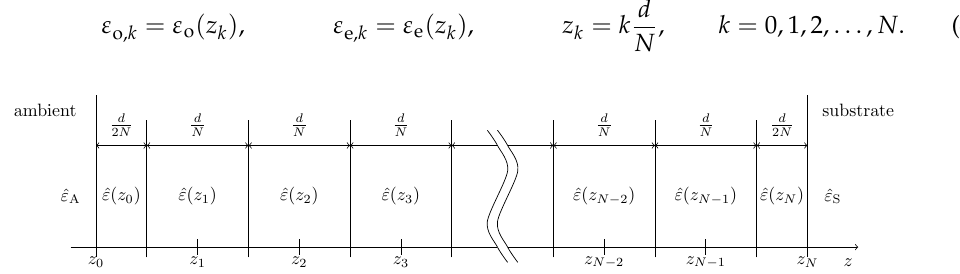
Figure 3. Schematic diagram of the system of thin homogeneous layers approximating the inhomo- geneous